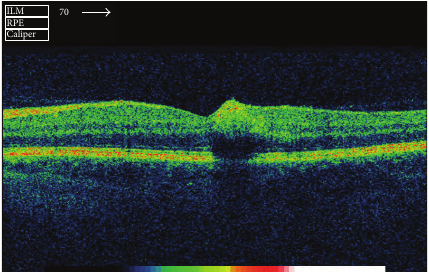
Figure 4: Spectral-domain optical coherence tomography scan of the left macula presenting intraretinal pseudocyst and hyperreflec- tive